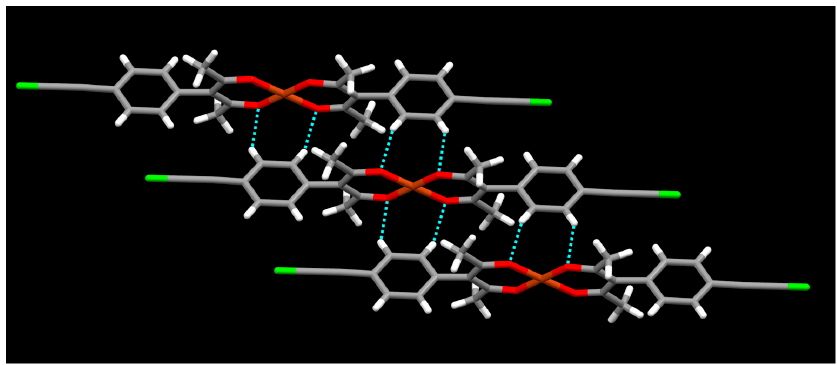
Figure 5. Relative orientation of complex ions within an infinite stack in the structure of [Cu( L1 ) 2 ] (color codes: red—oxygen; green—chlorine; orange—copper).